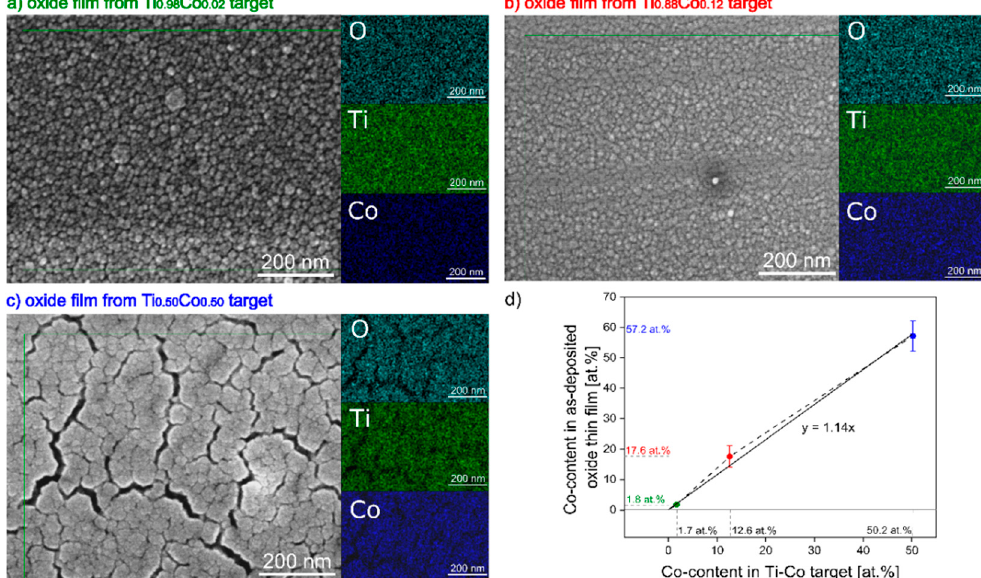
Figure 3. SEM images of surface topography with EDS maps of elemental distribution for oxide (Ti,Co)Ox thin films as deposited from: ( a ) Ti 0.98 Co 0.02 , ( b ) Ti 0.88 Co 0.12 , ( c ) Ti 0.50 Co 0.50 targets; with ( d ) a diagram of the dependence between Co-content in the target and in the oxide film.